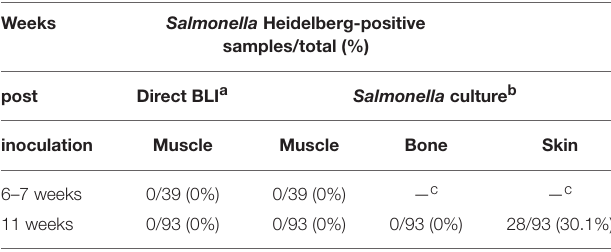
TABLE 2 | Salmonella prevalence in muscle, bone, and skin of turkeys infected with multiple S . Heidelberg isolates.